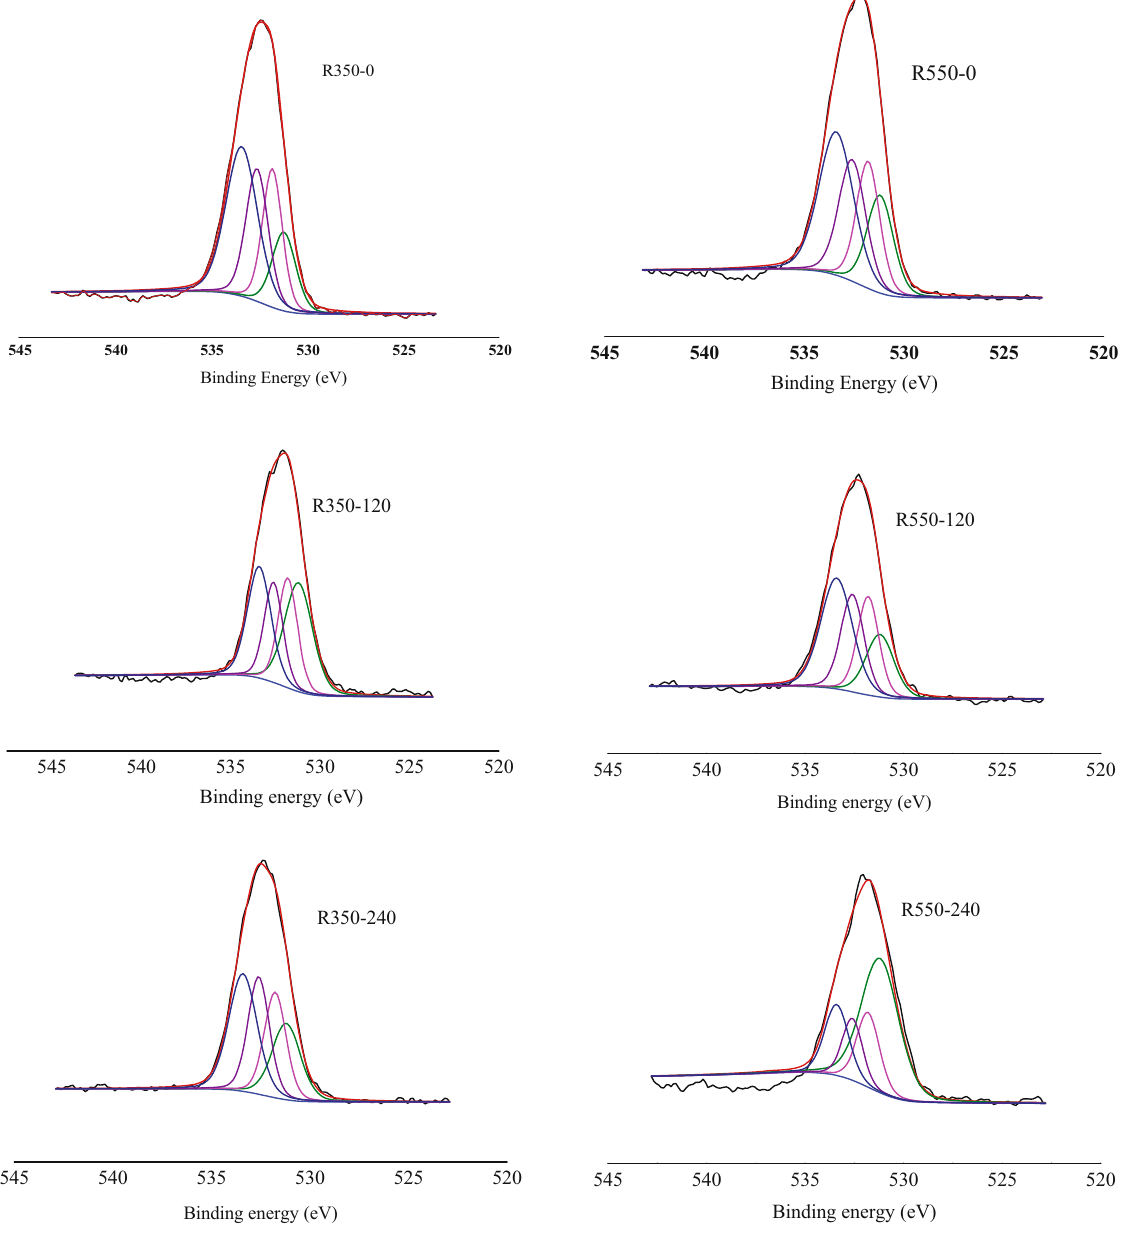
Figure 4: XPS O1 s scan and peak fi tting for the R350 and R550 biochar samples during ageing in soil for 0, 120 and 240